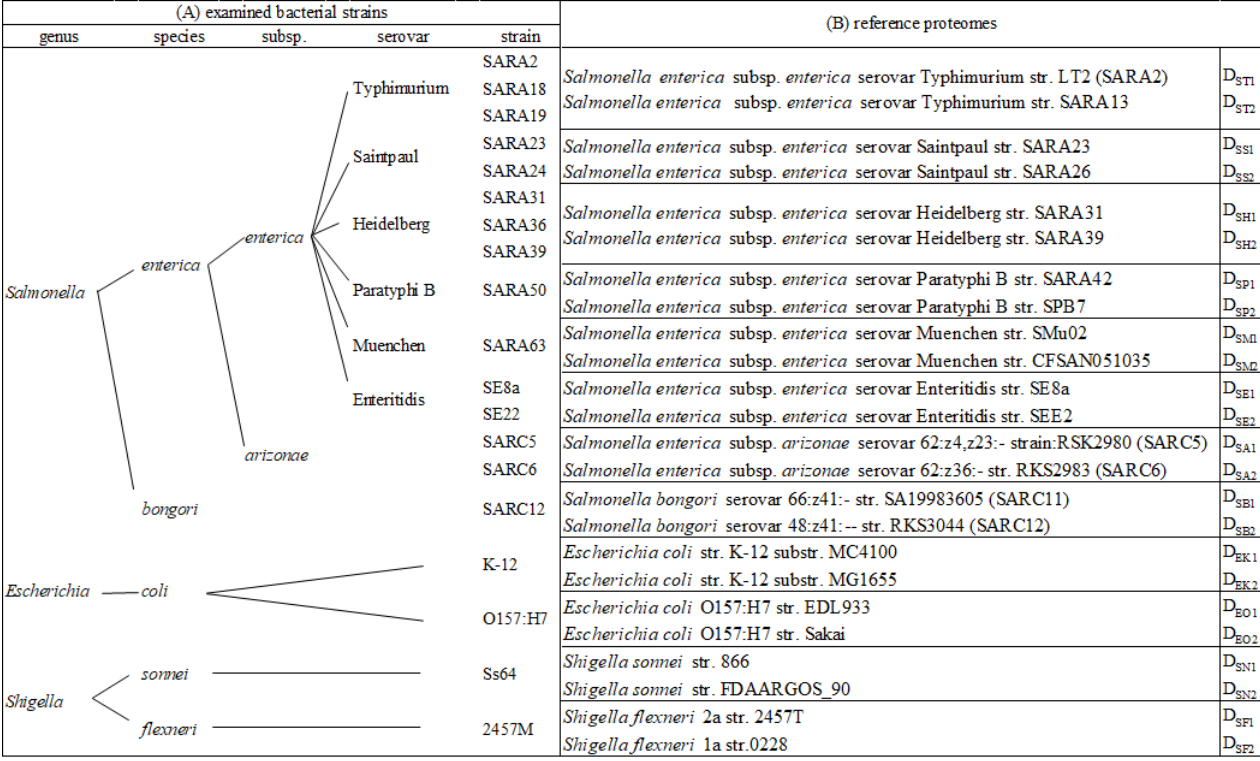
Figure 1. ( A ) Bacterial strains examined by proteomic analysis and ( B ) selected reference proteomes from proteome database used for peptide alignment and bacterial identification.